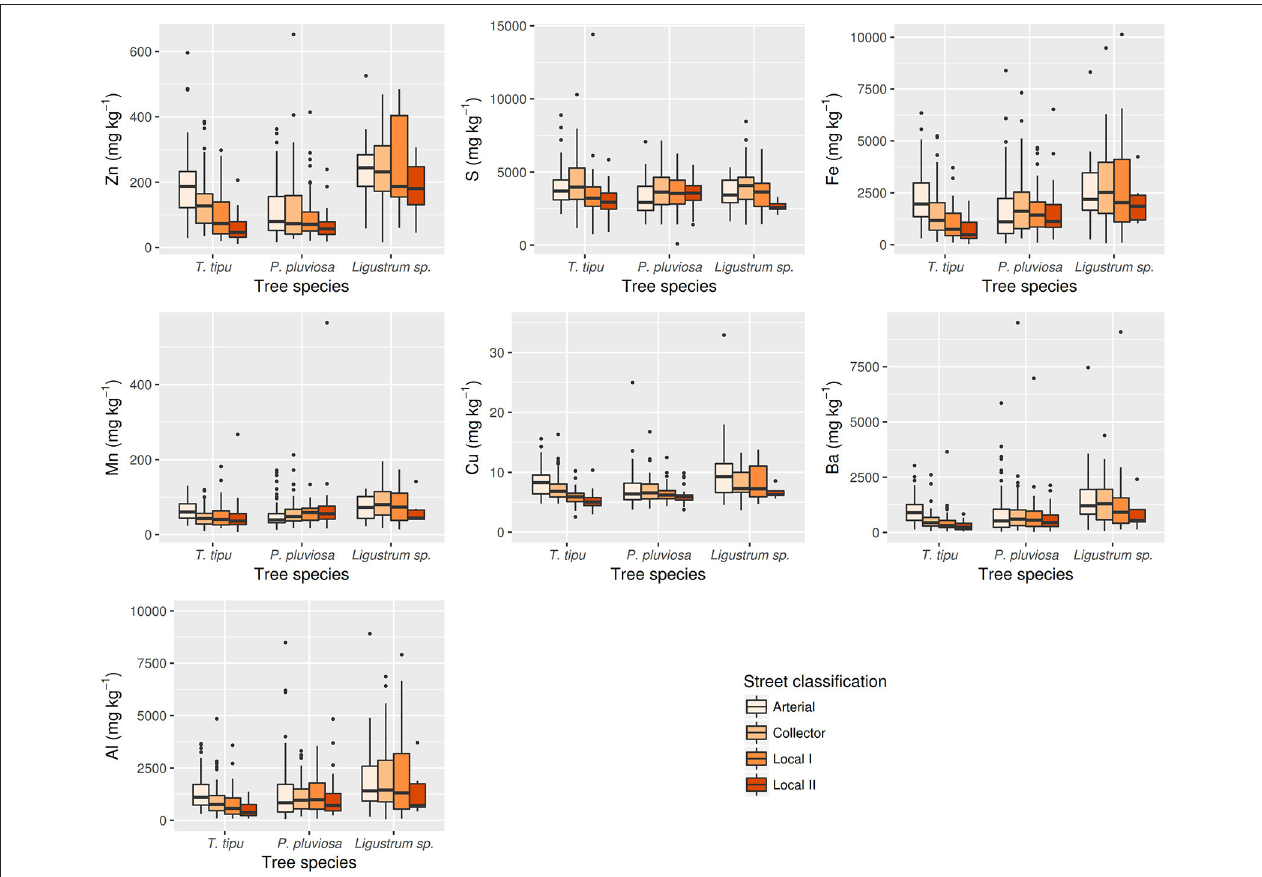
FIGURE 4 | Boxplots of elemental concentration on tree barks of Tipuana tipu, Poincianella pluviosa and Ligustrum sp. by different street categories: Arterial, Collector, Local I, and Local II.